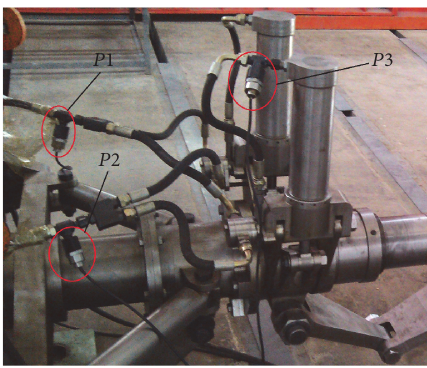
Figure 19: Dual actuator nose wheel steering mechanism.